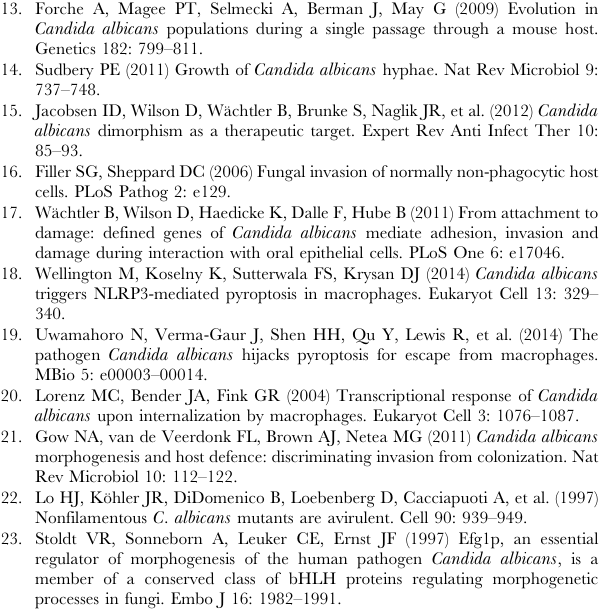
S5 Figure Characterization of the Evo SSN3 / ssn3 m D and Evo ssn3 D /SSN3 m strains. ( A ) Colony morphology of the Evo ssn3 D / SSN3 m strain grown on solid Lee’s medium, Spider medium and YPD medium supplemented with 10% FBS for 6 days at 37 u C (scale bar: 1 mm; representative pictures are shown). Observed morphologies resemble those of the Evo strain. ( B ) Stress resistance of cph1 D / efg1 D , Evo, Evo SSN3 / ssn3 m D and Evo ssn3 D /SSN3 m strains against different cell wall perturbing agents. The presence of either SSN3 allele has no influence on the increased stress resistance of the Evo strain. Experiments yielded similar results for at least three replicates.